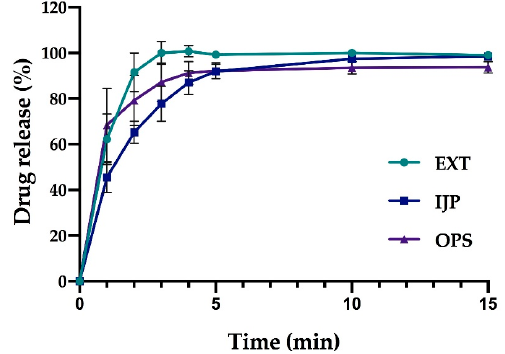
Figure 9. On-line in vitro drug release (%) of the different dosage forms conducted in 500 mL of purified water at 50 rpm, average ± SD, n = 3.